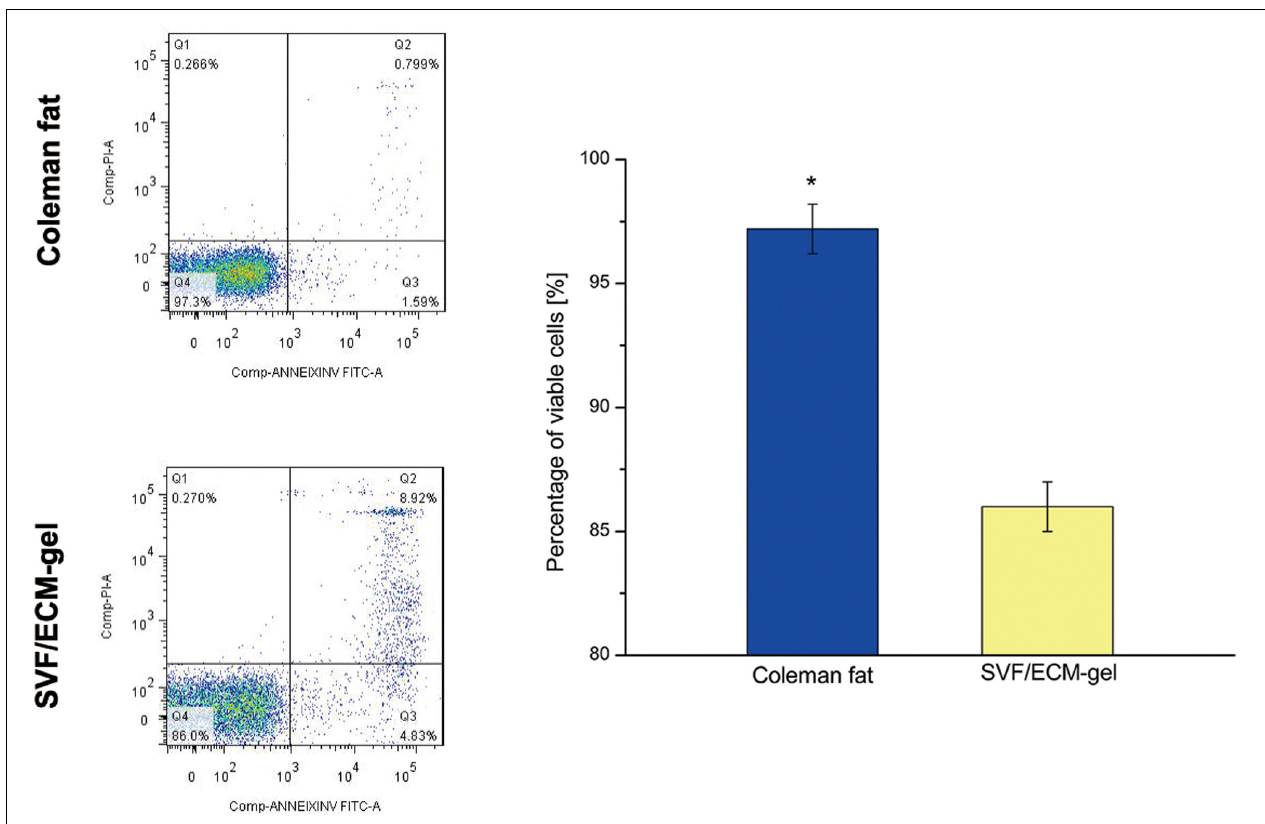
FIGURE 6 | SVF cell activity of the fat grafts. The apoptosis of SVF cells was detected using flow cytometry with Annexin V/PI double staining in Coleman fat and the SVF/ECM gel. * P <